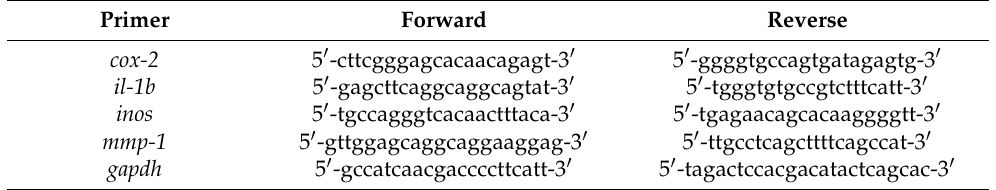
Table 2. Oligonucleotide